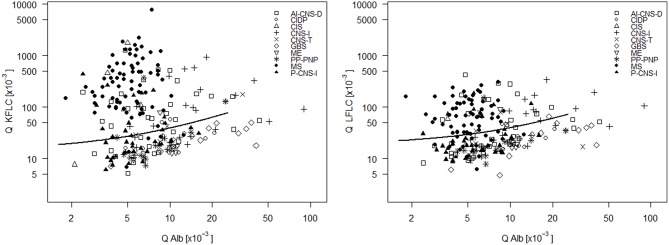
CSF- serum ratio of kappa free light chain (Q KFLC) (left) and lambda free light chain (Q LFLC) (right) is plotted against CSF-serum ratio of albumin (Q Alb). Solid line indicates the upper reference value introduced in Figure 2. AI-CNS-D, other autoimmune disease of the central nervous system; CIDP, chronic inflammatory demyelinating polyneuropathy; CIS, clinically isolated syndrome; CNS-I, viral and bacterial CNS infection; GBS, Guillain-Barré syndrome; ME, metabolic encephalopathy; MS, multiple sclerosis; PP-PNP, paraproteinemic neuropathy and/or neuropathy with monoclonal gammopathy of unknown significance; P-CNS-I, post-infectious CSF syndrome.